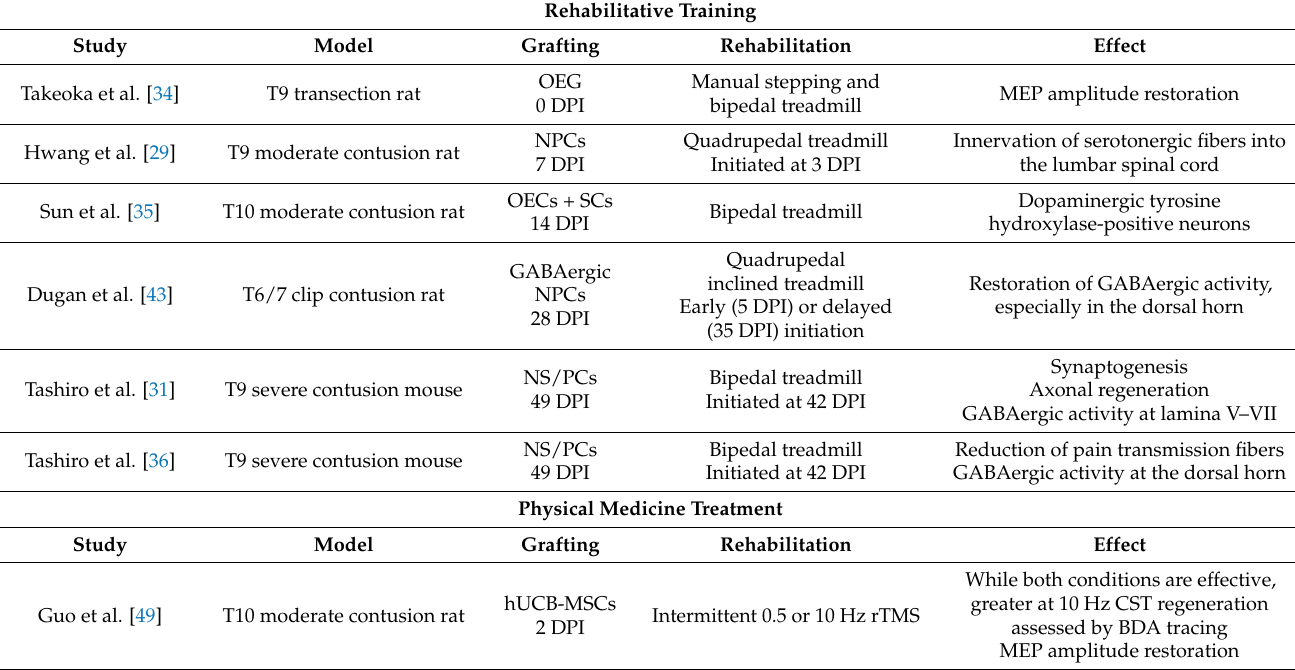
Table 3. Effects on the microstructure of spinal cord tissue distant from the